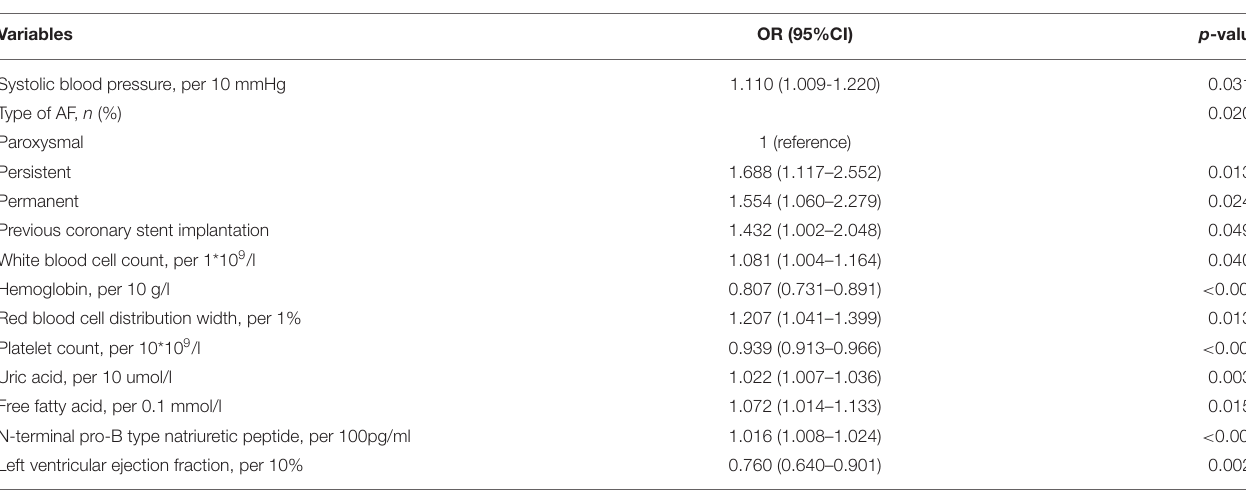
TABLE 2 | Independent factors related to big ET-1 ≥ 0.54